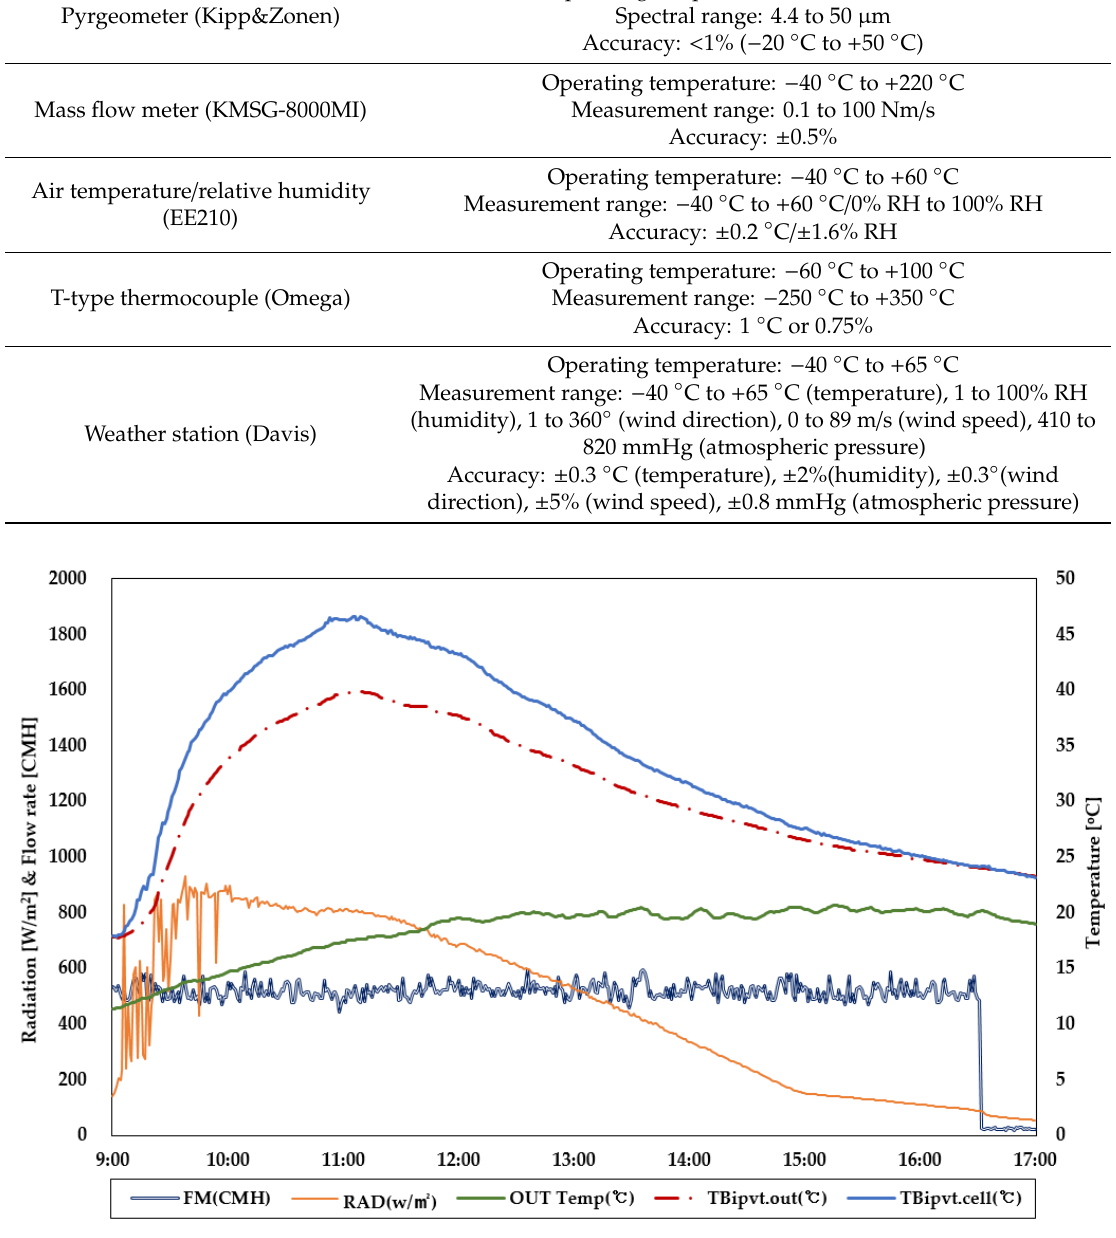
Figure 14. Daily ambient condition of an air-type BIPVT collector.